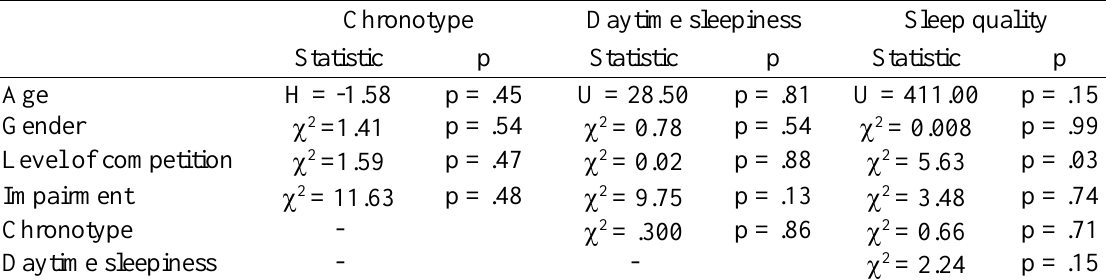
Table 2. Associations between the sample characteristics and sleep-related